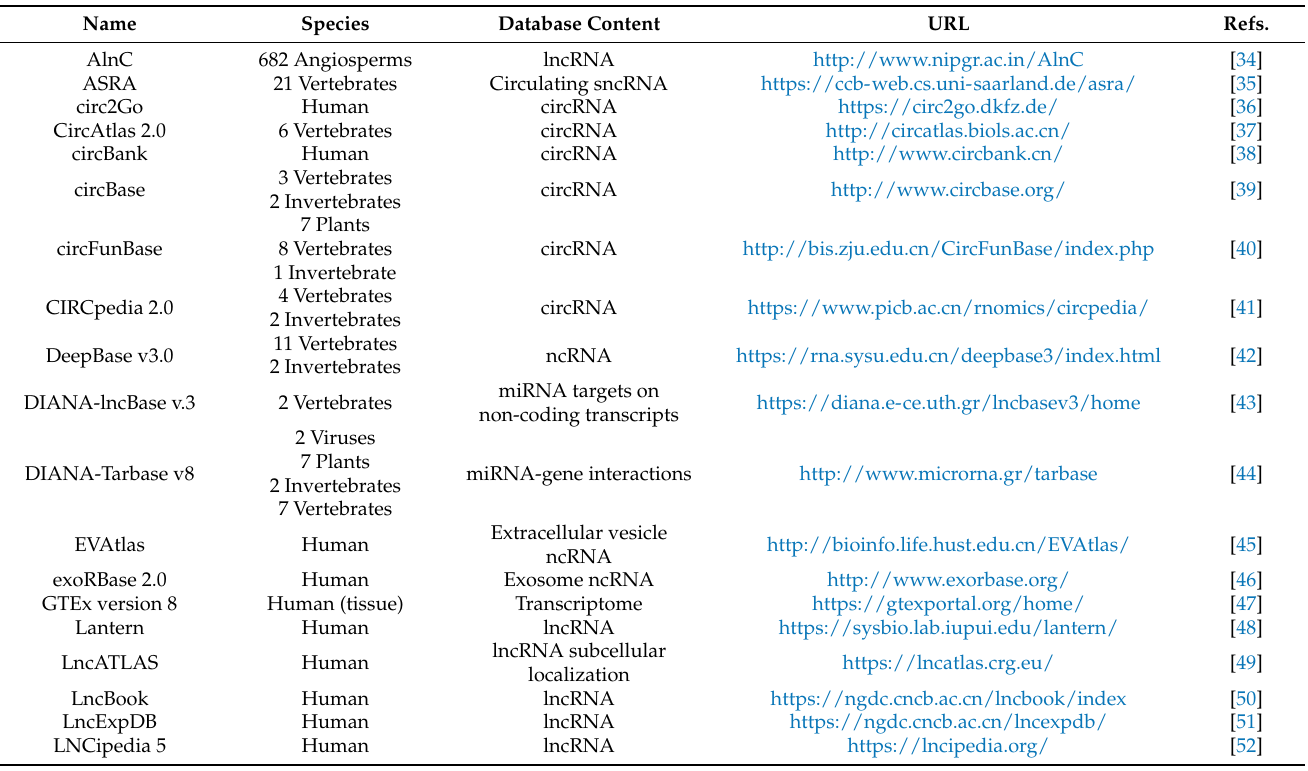
Table 1. A collection of recently developed or updated non-coding RNA databases containing NGS generated data. All URLs were accessed on 22 October